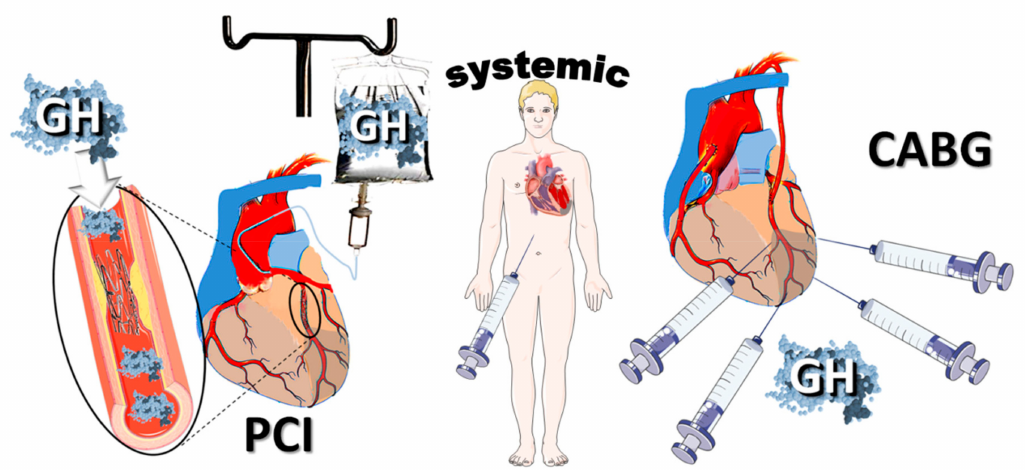
Figure 9. Routes for Growth hormone (GH) administration. GH could be administered via the intracoronary route in patients undergoing primary percutaneous interventions (PCI) for acute myocardial infarction. Direct intra-myocardial injections present an alternative route in patients undergoing coronary artery bypass grafting (CABG); it has the advantage of sustained action of GH via sca ff olds enabling controlled release. Systemic administration is a valid option in the remaining